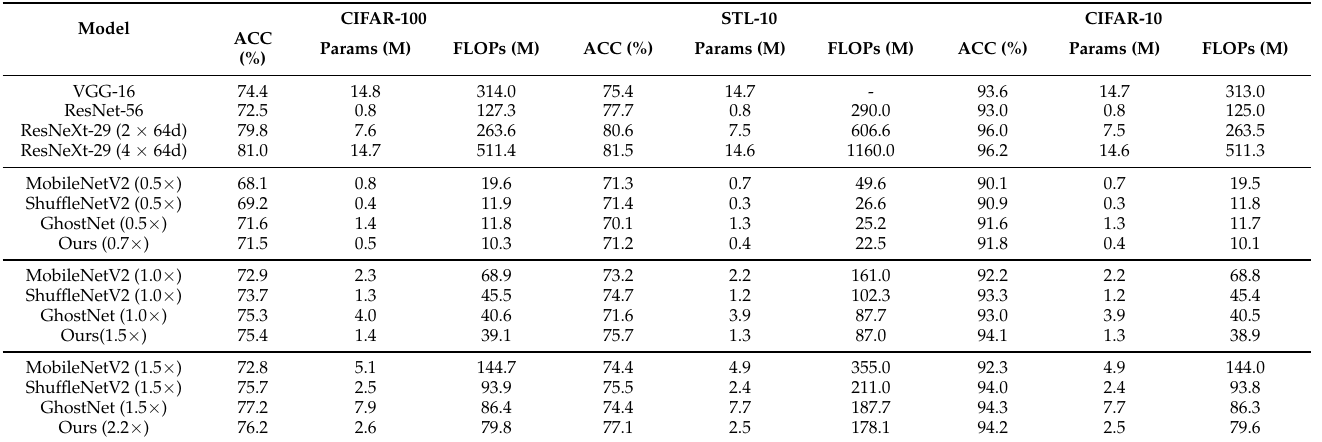
Table 3. Performance on the CIFAR-100, STL-10, and CIFAR-10 datasets.